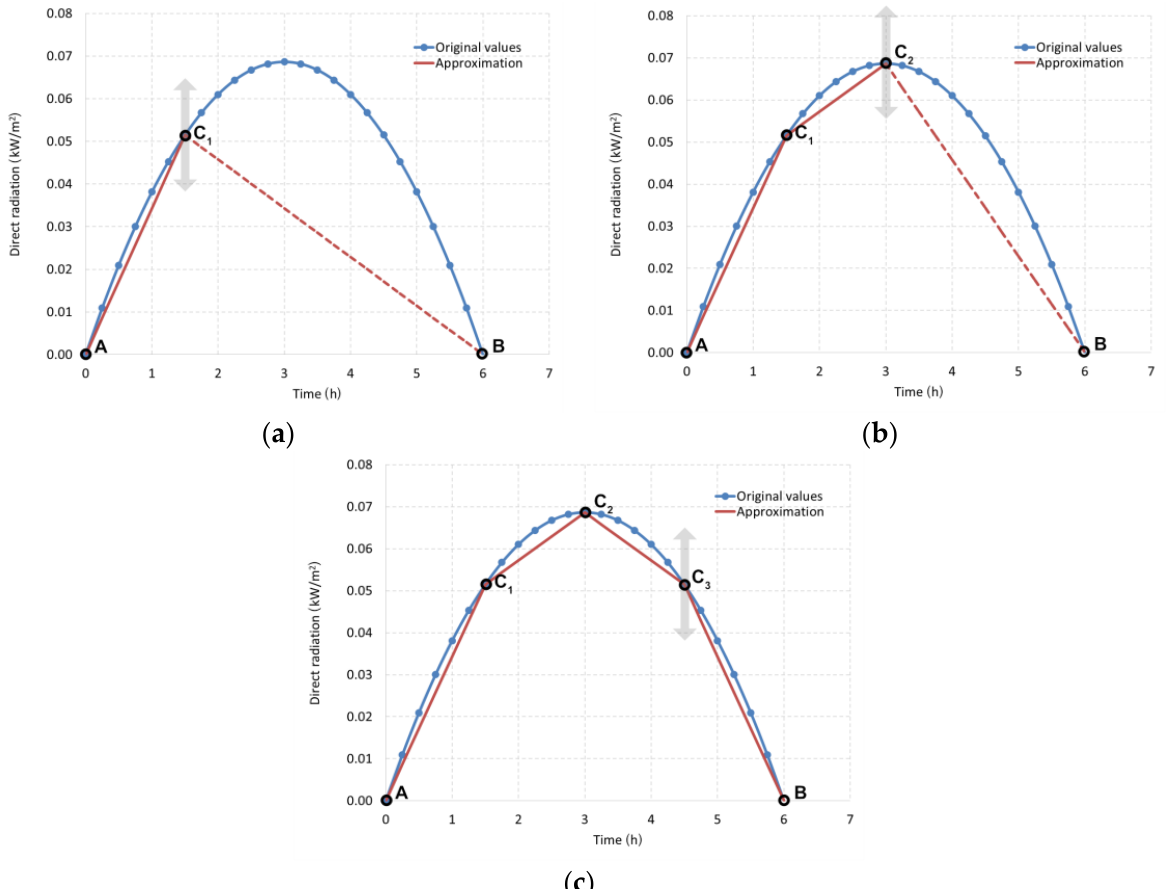
Figure 5. MEE scheme for three internal points (4 elements)—illustration of the proposed solution process: ( a ) the first phase of the process—solution for internal point C1; ( b ) the second phase of the process—solution for internal point C2; ( c ) the third phase of the process—solution for internal point